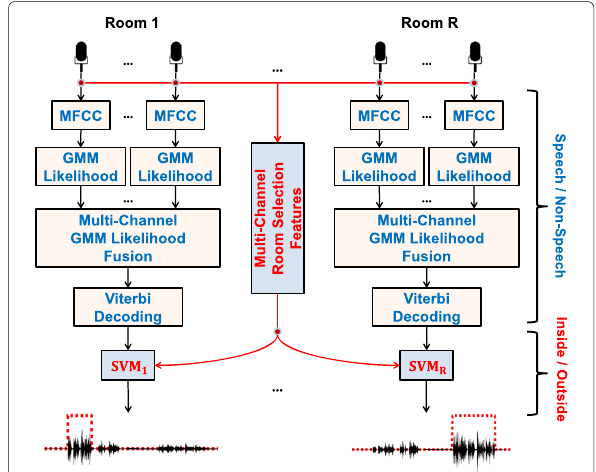
Fig. 2 Block diagram of the proposed room-localized SAD system. The first-stage algorithmic components are depicted in blue and the second-stage ones in